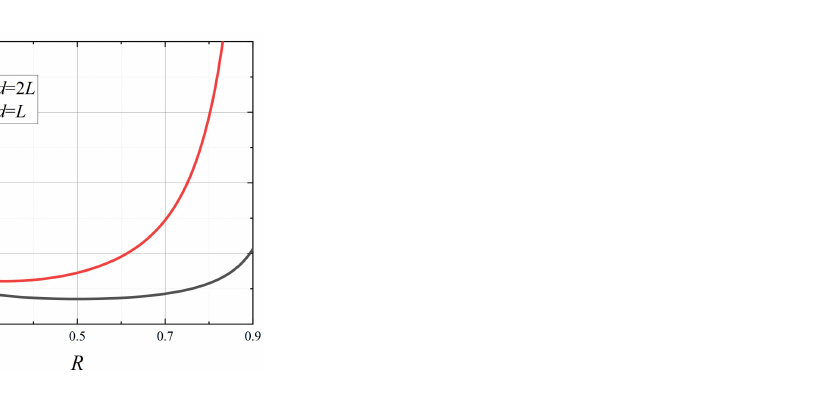
Figure 13. Relationship between the condition number κ and reflectance R at 2 nd = 2 L and 2 nd = L